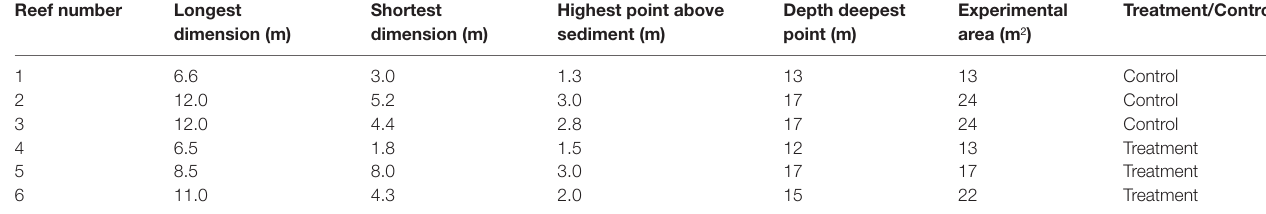
Shortest Highest point above dimension (m) sediment (m)